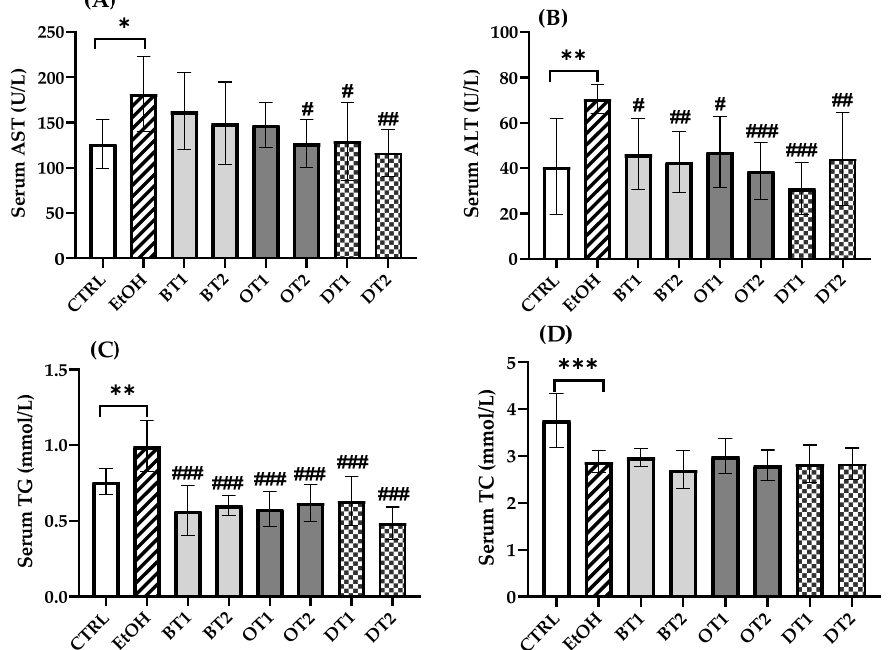
Figure 2. The effects of teas on serum biochemical markers in mice exposed to chronic alcohol consumption. ( A ) AST, aspartate transaminase; ( B ) ALT, alanine aminotransferase; ( C ) TG, triacylglycerol; ( D ) TC, total cholesterol. CTRL, the control group; EtOH, the model group; BT1, Dianhong Tea; BT2, Yingde Black Tea; OT1, Tieguanyin Tea; OT2, Fenghuang Danzong Tea; DT1, Fu Brick Tea; DT2, Selenium-Enriched Dark Tea. * p < 0.05, ** p < 0.01, *** p < 0.001, the model group compared with the control group; # p < 0.05, ## p < 0.01, ### p < 0.001, the tea extract supplementary groups compared with the model group.